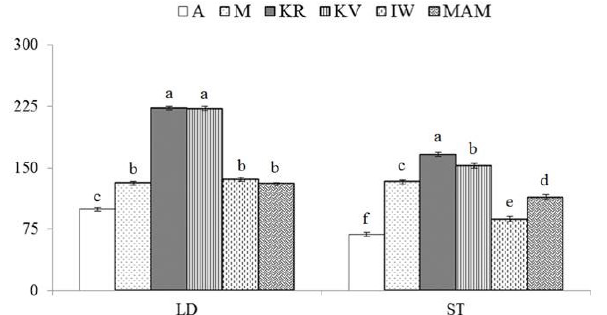
Figure 1. Cholesterol content in longissimus dorsi (LD) and semi- tendinosus (ST) muscles from male lambs born to Turkish indige-